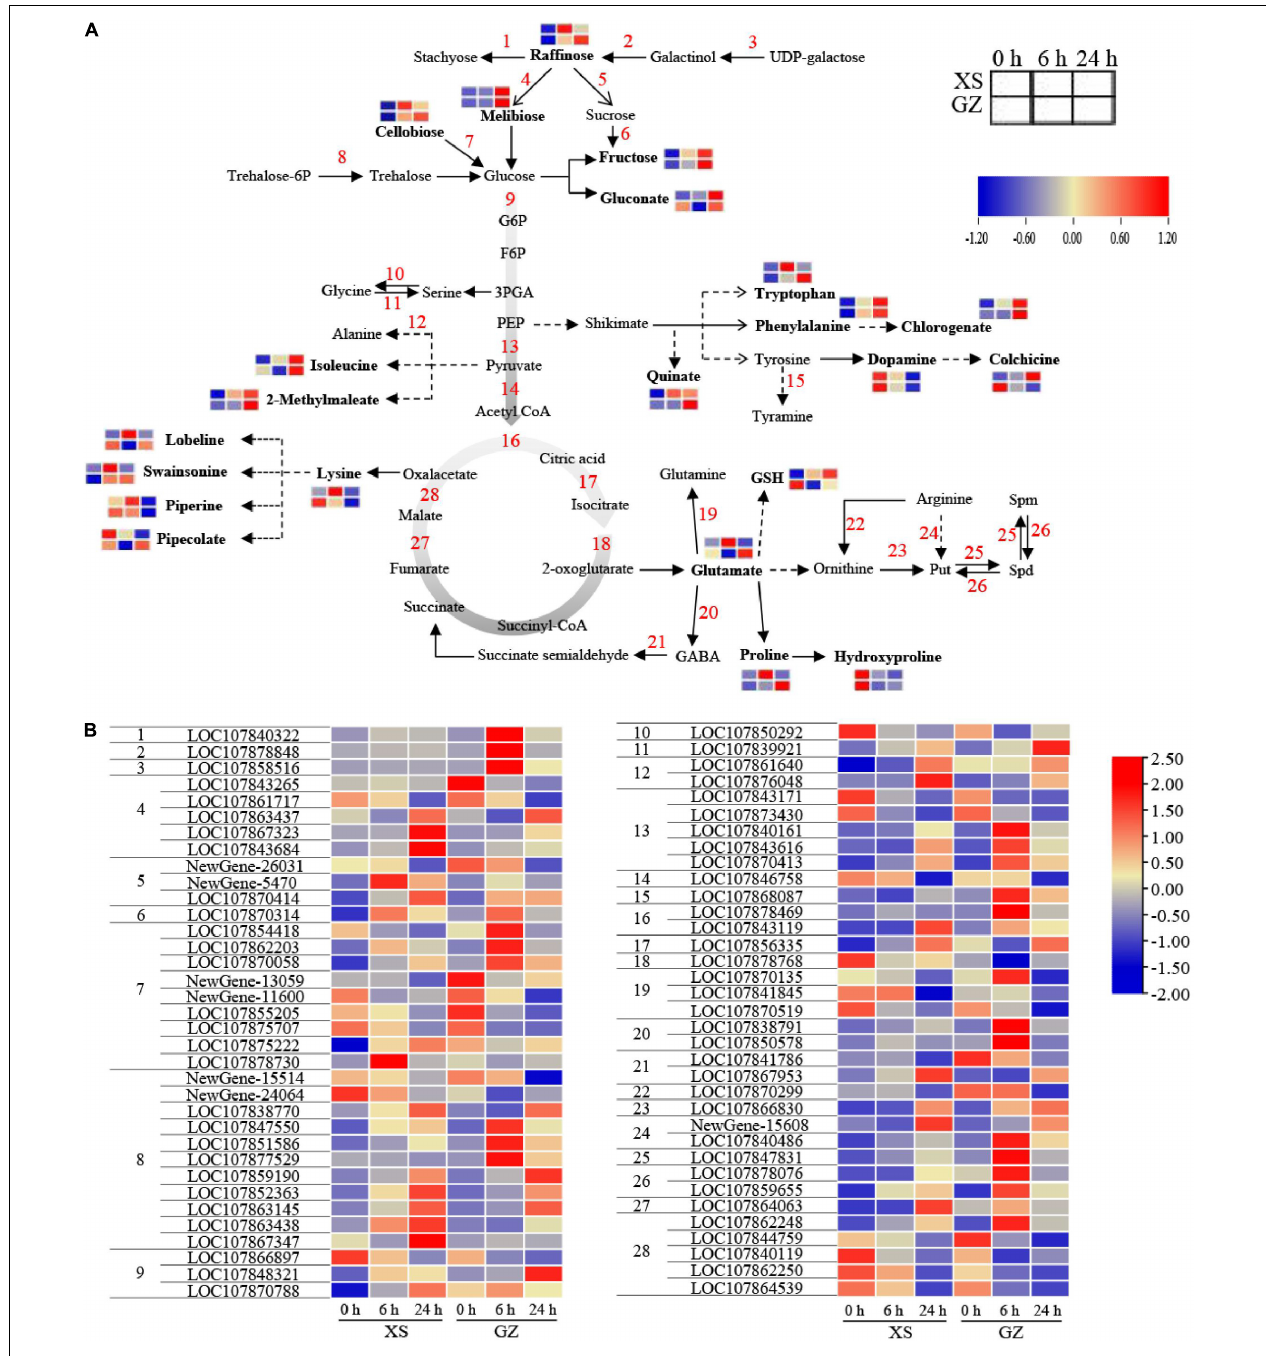
FIGURE 7 | Adaptive changes involved in sugar and amino acid metabolic pathways in cold-sensitive cultivar XS and cold-tolerant cultivar GZ under cold stress. (A) Metabolic changes in XS and GZ under cold stress. (B) Transcriptional changes of the genes in XS and GZ under cold stress. Each graph represents the normalized intensity of the corresponding metabolite or genes at different sampling